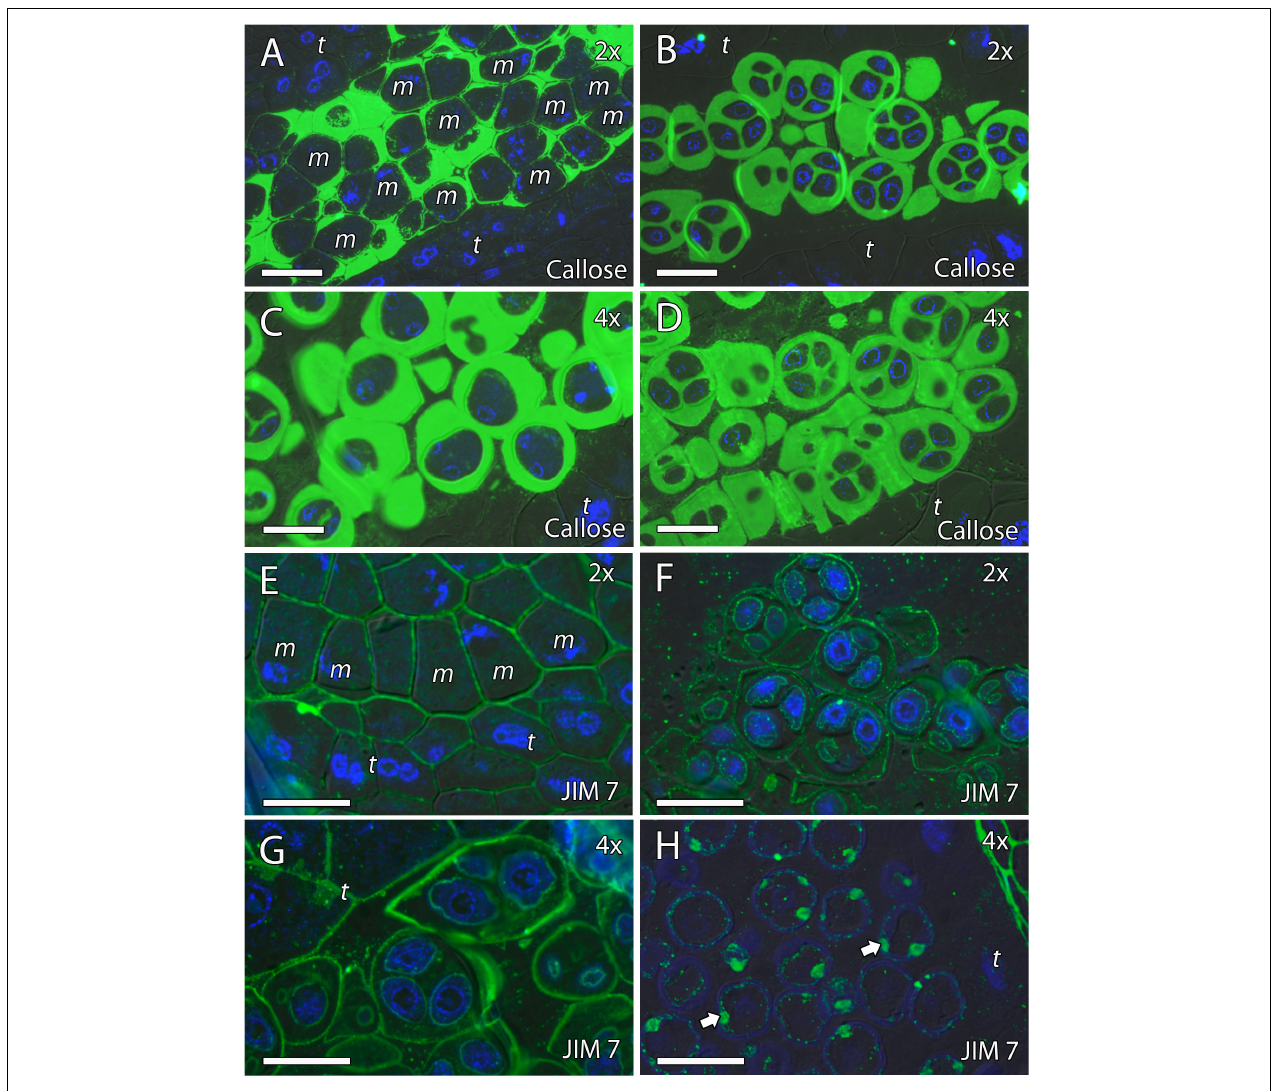
FIGURE 3 | Inmunolocalization of callose and pectins during microsporogenesis in diploid and doubled diploid “Sanguinelli” blood orange. Monoclonal antibodies used: (A–D) anti-callose against callose and (E–H) JIM7 against methyl-esterified pectins. (A,C) Anti-callose labeling around MiMCs. (B,D) Callose prominently present around four microspores during simultaneous cytokinesis. (E) Pectins present in the MiMC wall. (F,G) Pectins present surrounding the microspores and in the early microspore wall. (H) Pectins observed in the aperture sites (arrows). All scale bars = 25 µ m. MiMC (m), tapetum (t), diploid (2x), and doubled diploid